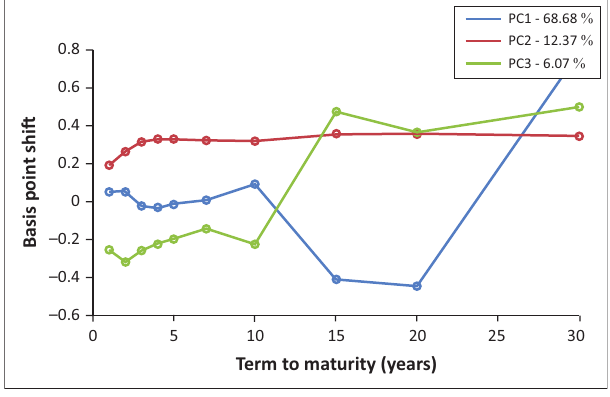
FIGURE 7: The three most important factors driving movements in South African swap rates: 2000–2014.